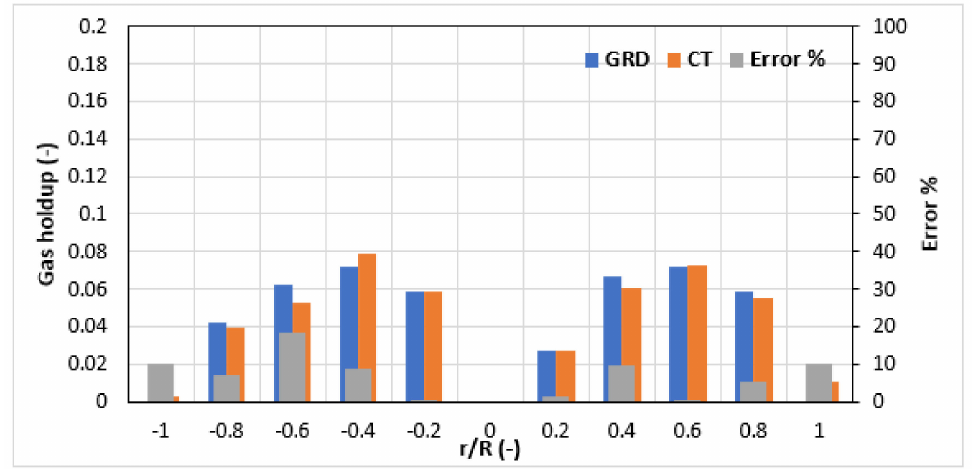
Figure 8. The compression curves between GRD and CT experimental data of the gas holdup and their percentage error at medial section and operated at 3 cm/s (gas